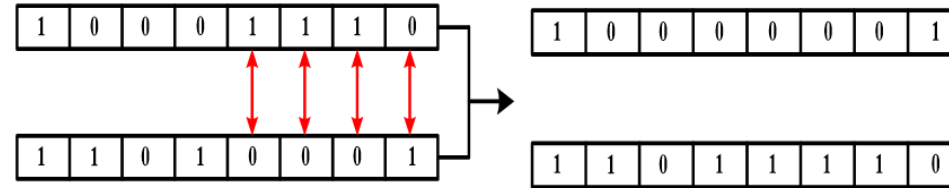
Figure 9. Different types of individuals. A number four between one and seven is randomly generated using the crossover operation to exchange the last four digits of P1 and P2, and a new individual can be obtained. The exchange process is shown in Figure 10.